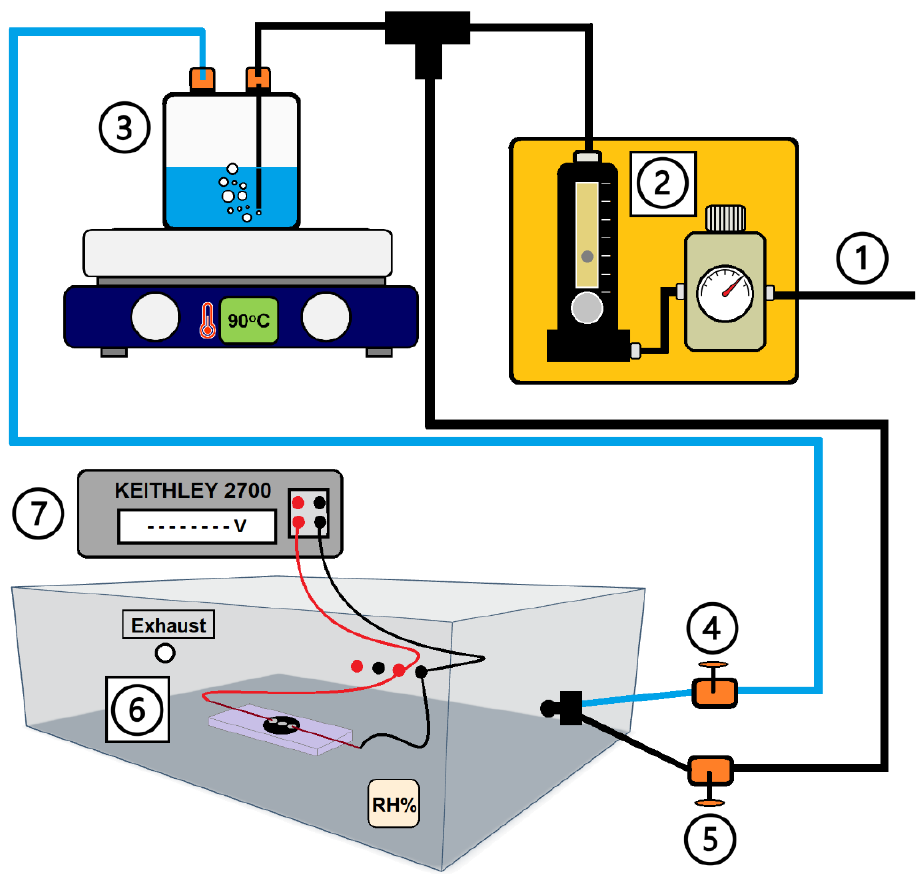
Figure 2. Schematic representation of custom experimental set-up built for moisture-induced voltage measurements. The components are 1 (cid:13) N 2 gas inlet, 2 (cid:13) pressure regulator and flow meter, 3 (cid:13) water heating on a hotplate (90 ◦ C) for moisture production, 4 (cid:13) moisture inlet valve for humidification of the chamber, 5 (cid:13) N 2 gas inlet valve for purging and dehumidification of chamber, 6 (cid:13) MEG